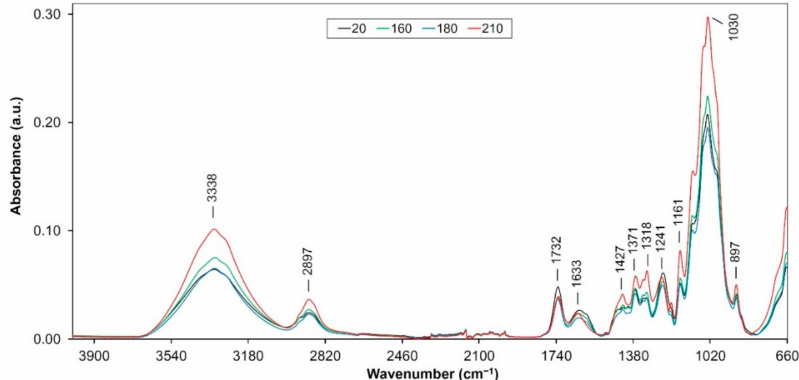
Figure 2. FTIR spectra of the thermally treated holocellulose from oak